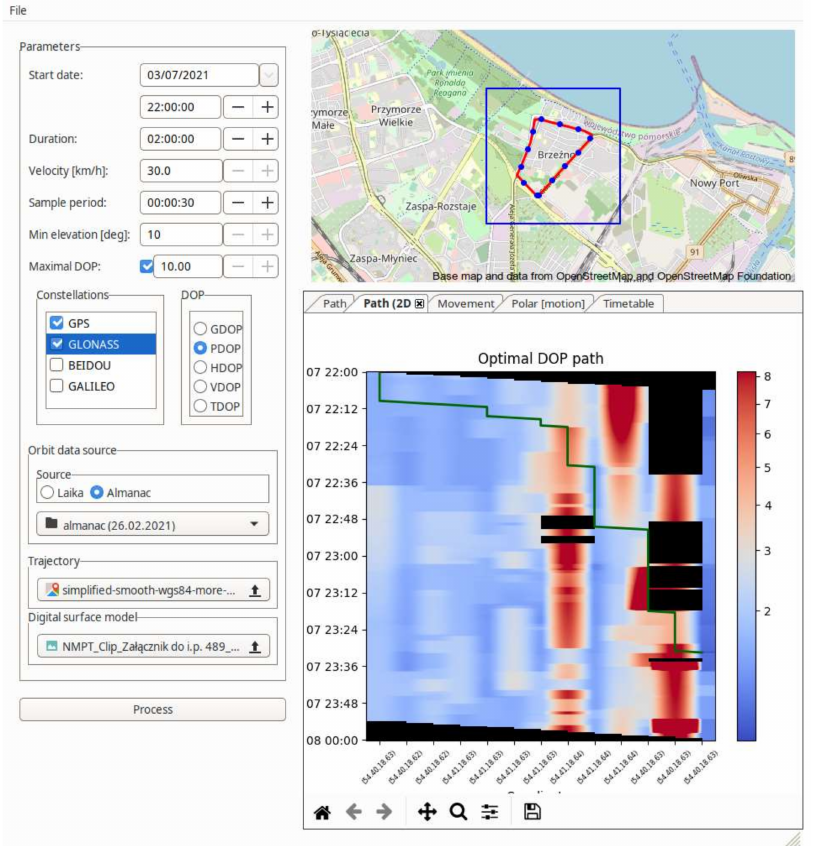
Figure 1. The main window of the software for the planning of a linear object GNSS measurement